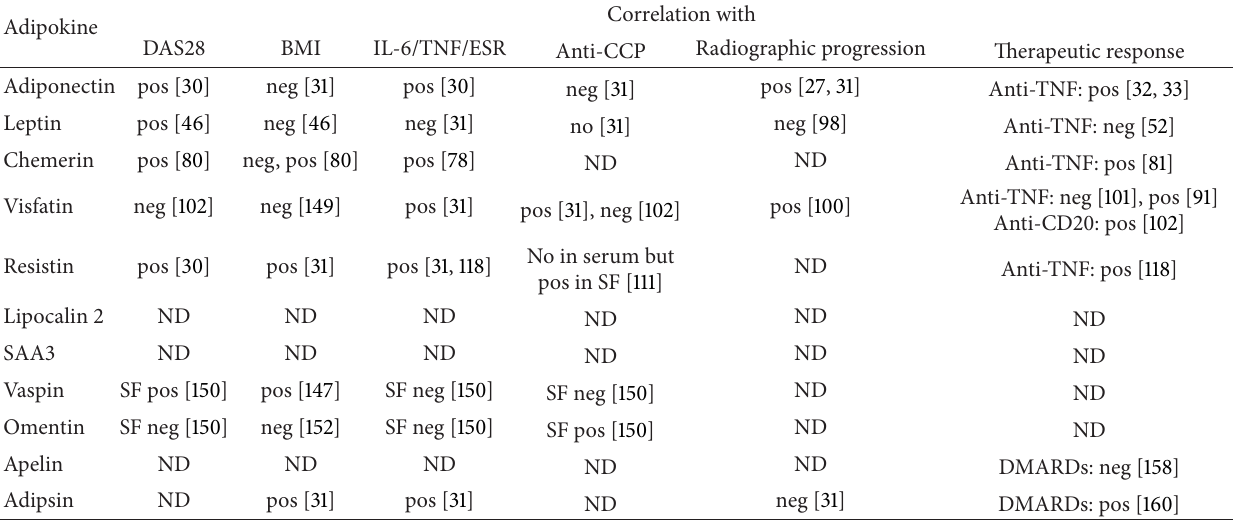
Table 1: Correlation of adipokines with disease activity parameters and therapeutic response.